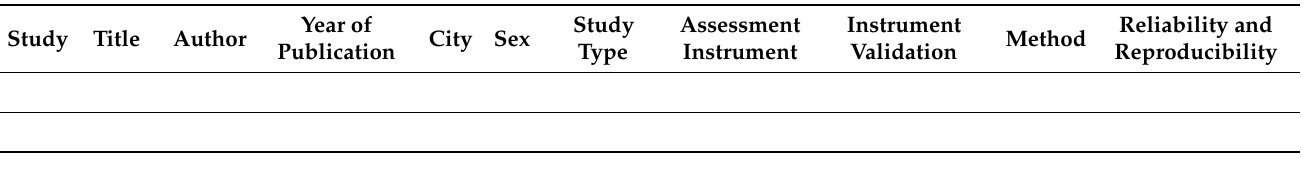
Table 2. Summary of data extracted from the identified